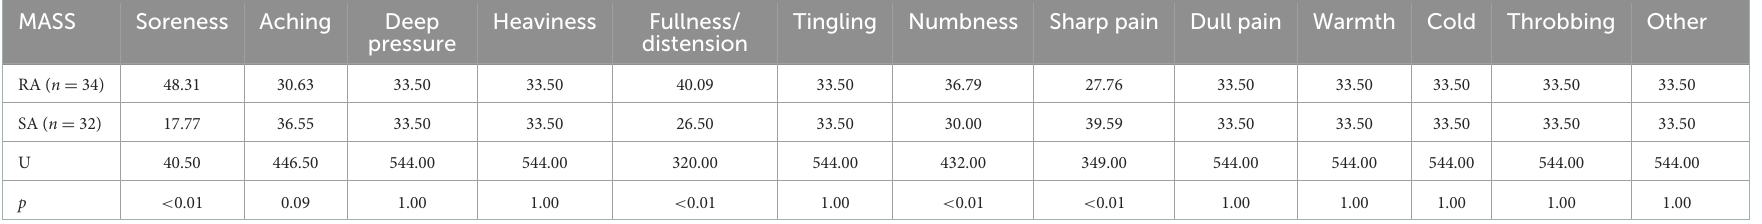
TABLE 10 Degree of each participants-reported needle sensation recorded by MASS (participants = 66). MASS Soreness Aching Deep Heaviness Fullness/ Tingling Numbness Sharp pain Dull pain Warmth Cold Throbbing pressure distension